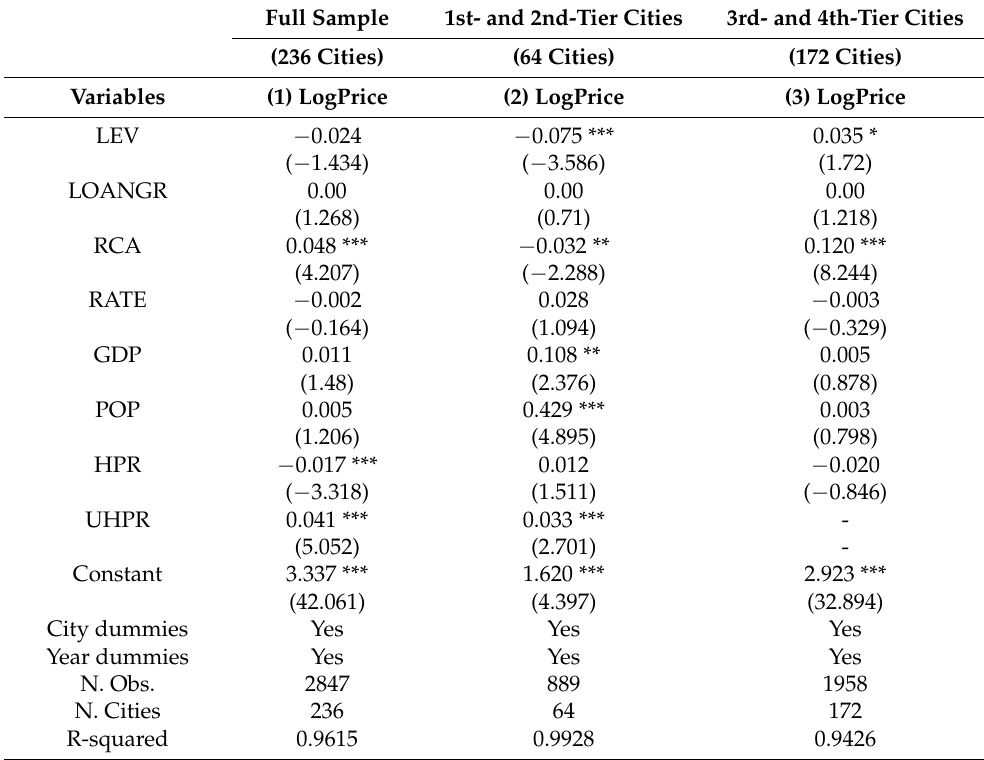
Table 3. Urban leverage and housing